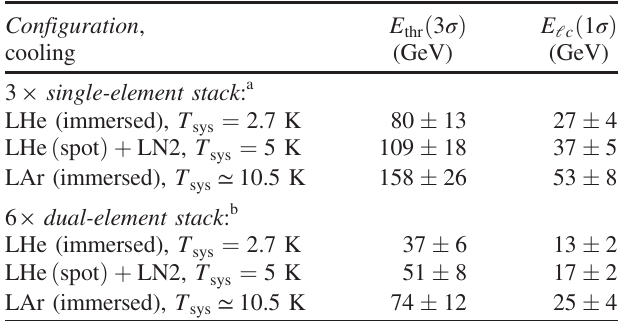
TABLE I. Estimated 3 σ particle energy threshold E least-count energy E l for CCF timing (based on shower c detection) for various ACE timing plane configurations as estimated by our 2018 beam test.